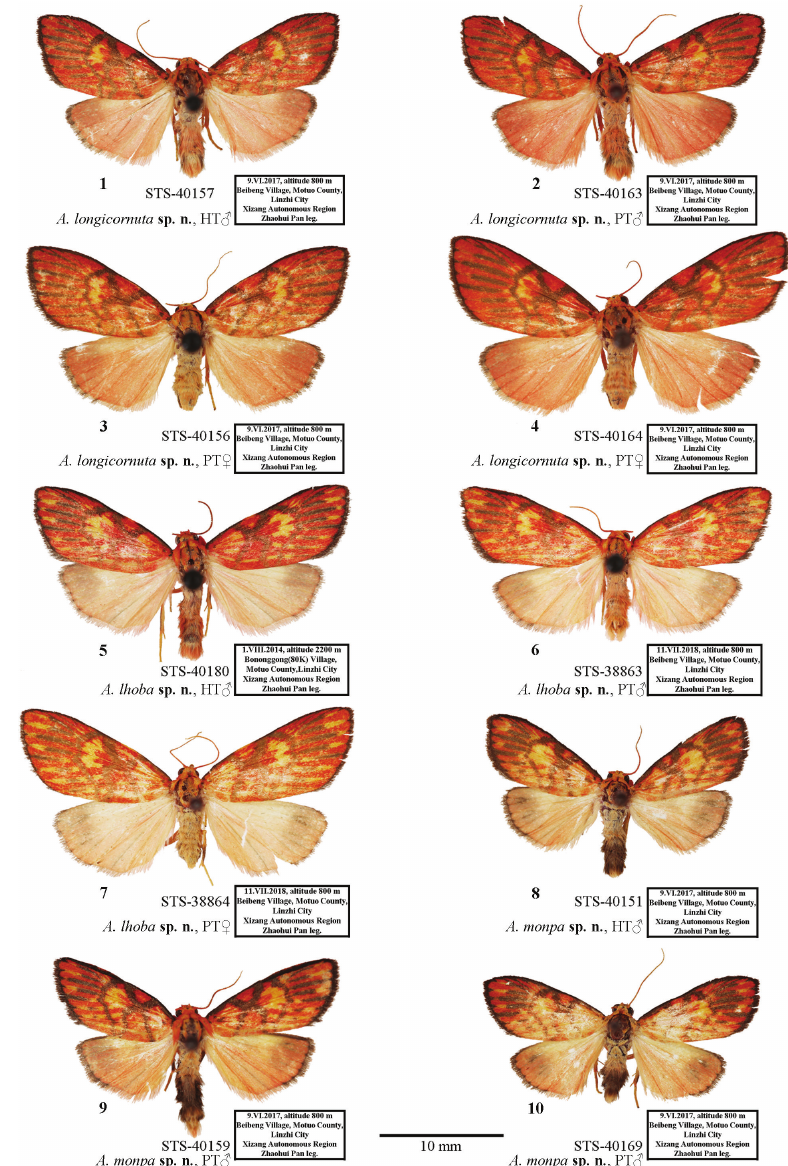
Figure 1–10. Adults of Ammathella 1 holotype of A. longicornuta sp. nov., male, STS-40157, SW China (TAAHU) 2 paratype of A. longicornuta sp. nov., male, STS-40163, SW China (TAAHU) 3 paratype of A. longicornuta sp. nov., female, STS-40156, SW China (TAAHU) 4 paratype of A. longicornuta sp. nov., female, STS-40164, SW China (TAAHU) 5 holotype of A. lhoba sp. nov., male, STS-40180, SW China (TAAHU) 6 paratype of A. lhoba sp. nov., male, STS-38863, SW China (TAAHU) 7 paratype of A. lhoba sp. nov., female, STS-38864, SW China (TAAHU) 8 holotype of A. monpa sp. nov., male, STS- 40151, SW China (TAAHU) 9 paratype of A. monpa sp. nov., male, STS-40159, SW China (TAAHU) 10 paratype of A. monpa sp. nov., male, STS-40169, SW China